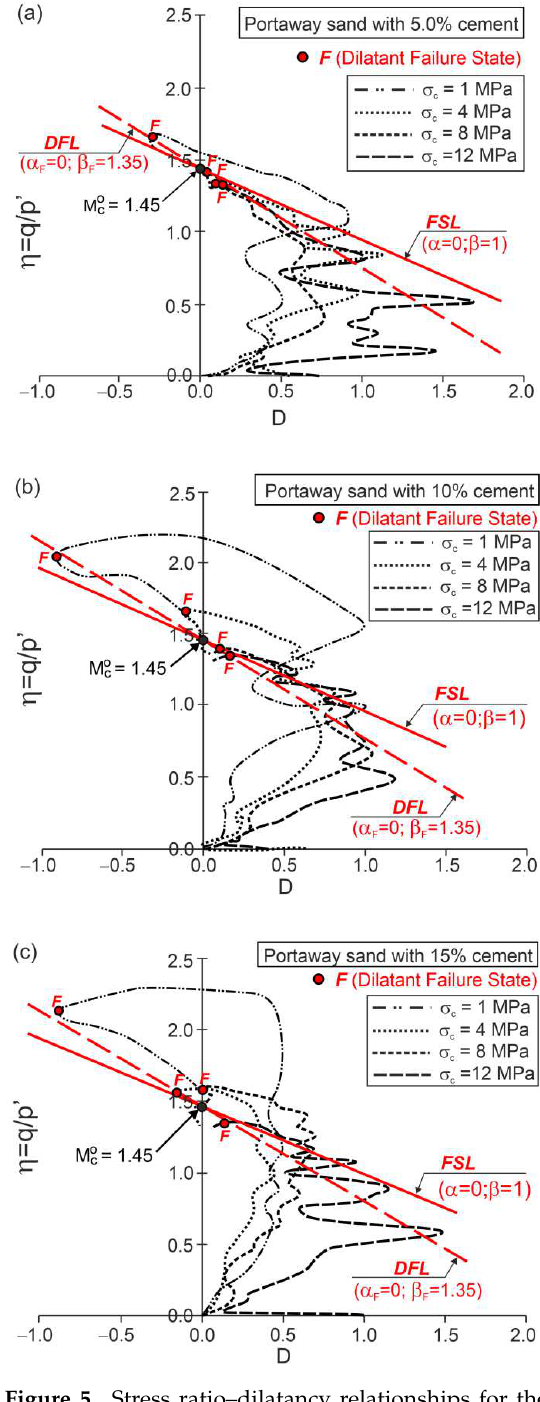
Figure 5. Stress ratio–dilatancy relationships for the drained triaxial compression of cemented Portaway sand: ( a ) 5% cement; ( b ) 10% cement; ( c ) 15% cement (adapted from [10]). For the undrained triaxial compression tests, the ultimate states (Figure 6) corre- spond to the critical frictional states ( (cid:13) (cid:14)(cid:15) = 1.45 ) defined by the intersecting DFL with the vertical axes in the (cid:1) − (cid:3) plane for the drained triaxial compression tests (Figure 5). The dilatant failure states are represented by characteristic points of the stress path in (cid:9) − (cid:10)′